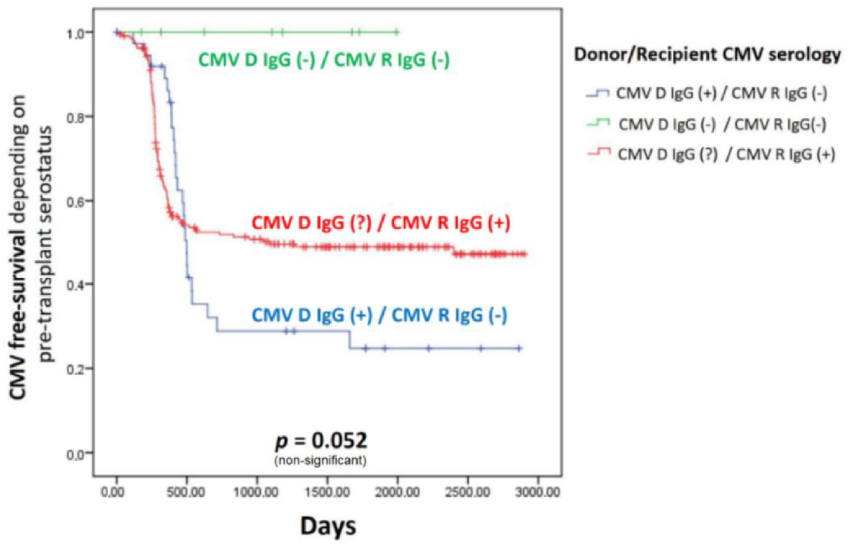
Figure 1. Donor/recipient CMV serology. The CMV serostatus of donor/recipient pairs influences the risk of CMV infection. The CMV-infection-free survival was shorter in the group of patients with CMV serostatus pairing between the donor and the recipient: D IgG (+)/R IgG ( − ) ( p = 0.052, non- significant).